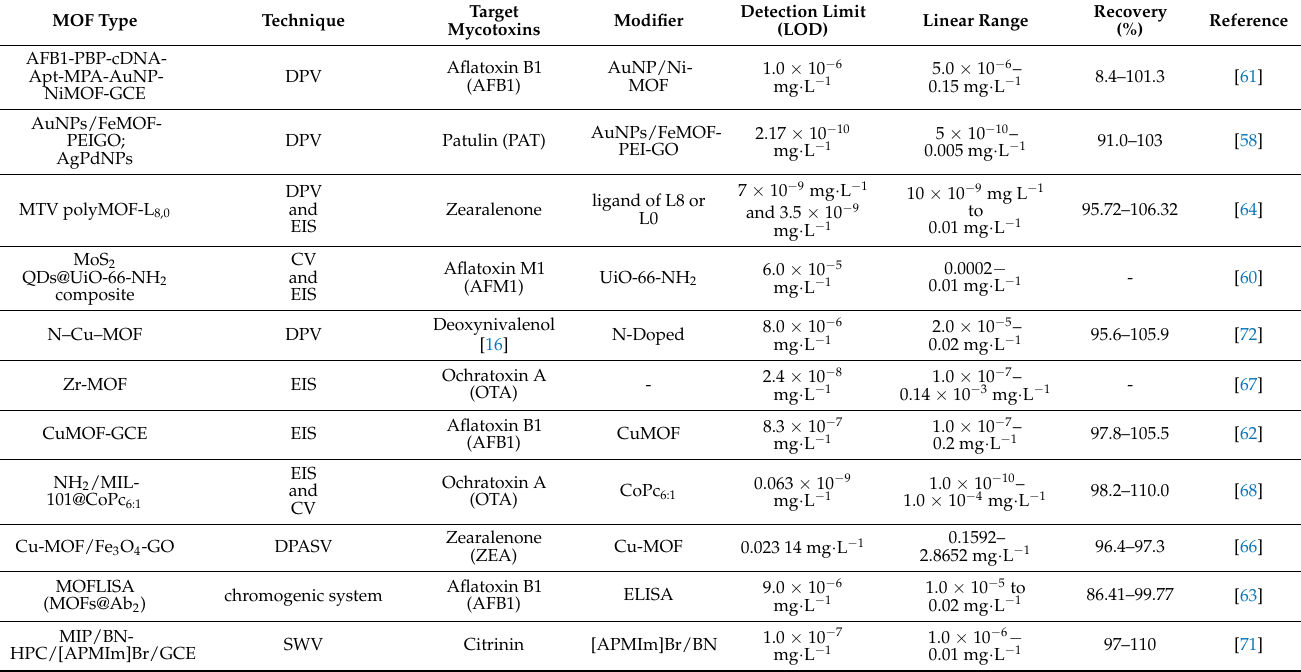
Figure 8. Schematic representation for the manufacture and operation of MIP/[APMIm]Br/BN- HPC/GCE, as well as the preparation process for BN-HPC (with permission from the article [71]). In another research project, Xiaoyan Wen et al. (2021) [72] modified an electrochemical aptasensor based on Cu–N–MOF. This sensor had a 2.0 × 10 − 5 to 0.02 mg/L (R 2 = 0.994) linearity concentration range with an 8.0 × 10 − 6 mg/L detection limit to detect deoxyni- valenol, one of the most prominent mycotoxins in the contaminated wheat sample. Table 1. Recent advances in electrochemical-based sensing platforms for detecting various kinds of mycotoxins in numerous food